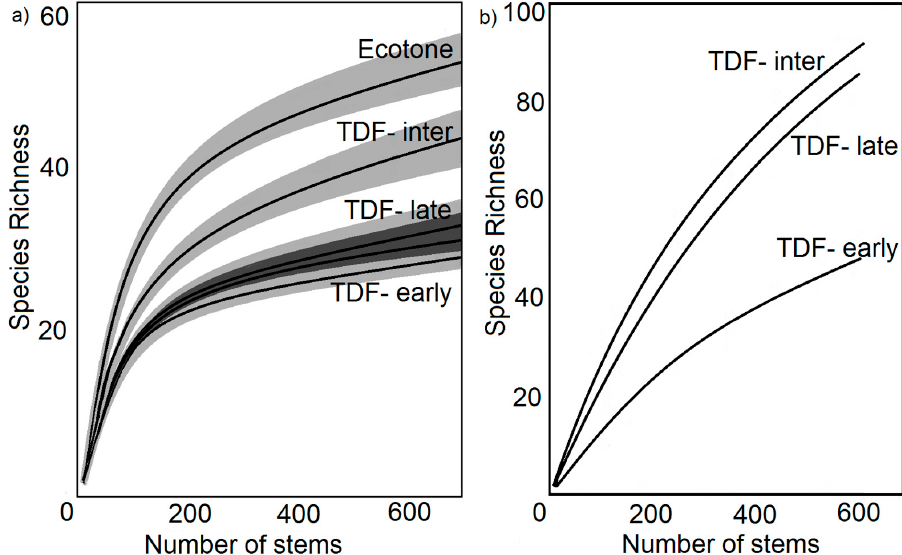
Figure 3. Species richness and the number of stems by successional stage reproduced from Minas Gerais, Brazil as found in Coelho et al. ( a ) [19] and from Santa Rosa National Park, Costa Rica, based on data from Kalacska et al. ( b ) [45]. Intermediate stage TDFs have the highest species richness of the secondary TDFs. The ecotone consists of a combination of primary TDF and savanna land.